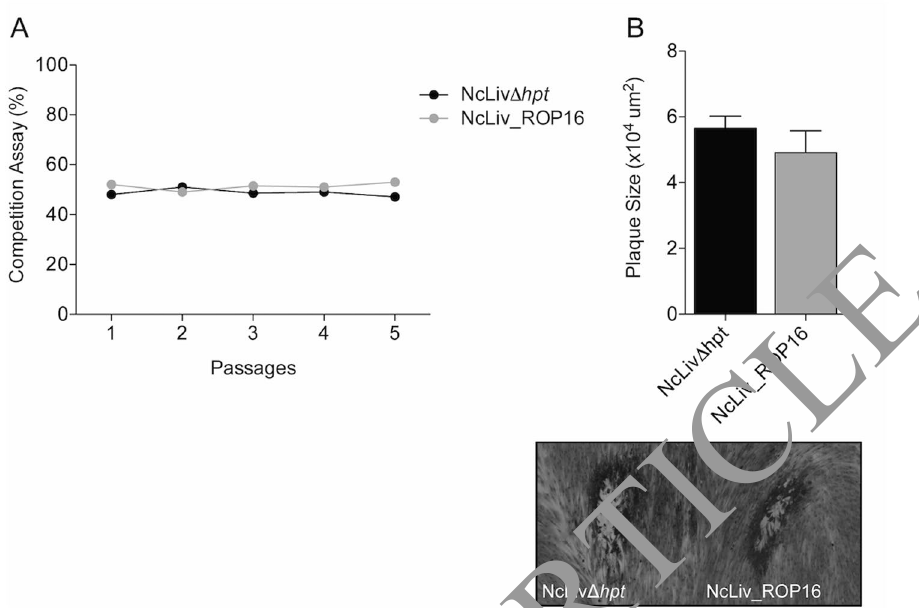
Figure 6. ROP16 expression in N. caninum does not compromise parasite fitness. ( A ) Growth competition assay of parental (NcLiv Δ hpt ) and NcLiv_ROP16 strains, co-cultured for 6 passages (80%/20% and 50%/50% proportions), ( B ) plaque formation of parental (NcLiv Δ hpt ) and NcLiv_ROP16 strains, based on multiple lytic cycles. The area of each plaque was determined at 8 days post infection. Values are representative of two independent experiments indicating mean ± SEM of plaque size ( * P < 0.05; Student’s